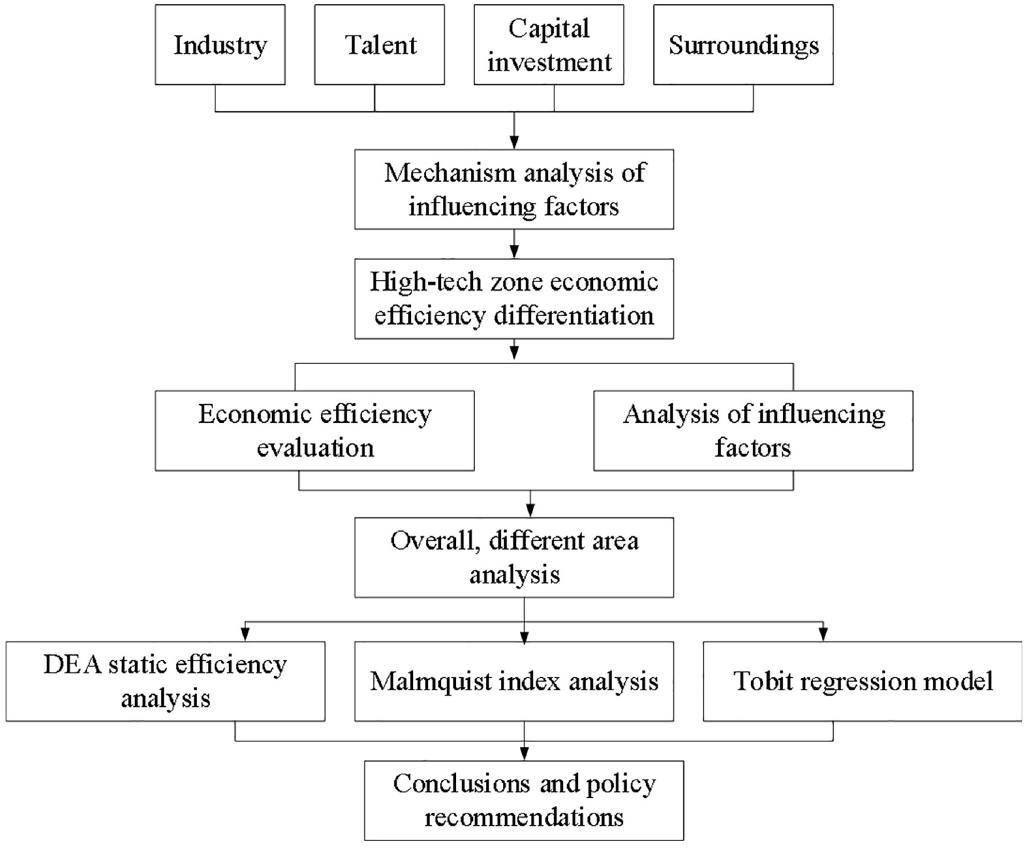
Fig 2. Operation flowchart of the system model.